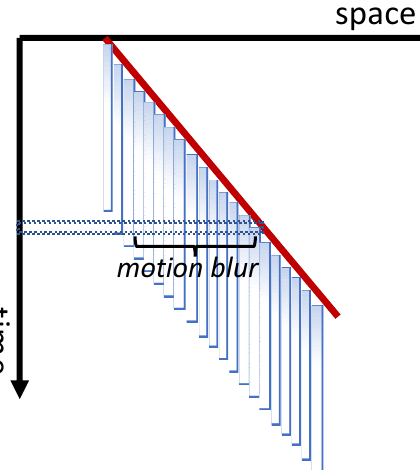
Figure 6. Illustration of motion smear that would result from rSM in response to a moving stimulus. A dot moves at a constant speed (red line) as plotted in the space-time diagram. At each retinotopic location, it generates a decaying activity, as illustrated by fading blue lines. The spatial profile at a given time (dashed horizontal area) consists of the stimulus and a trailing motion blur similar to a comet and its tail. Note that different colors do not refer to the color of the perception but are used to illustrate different components.